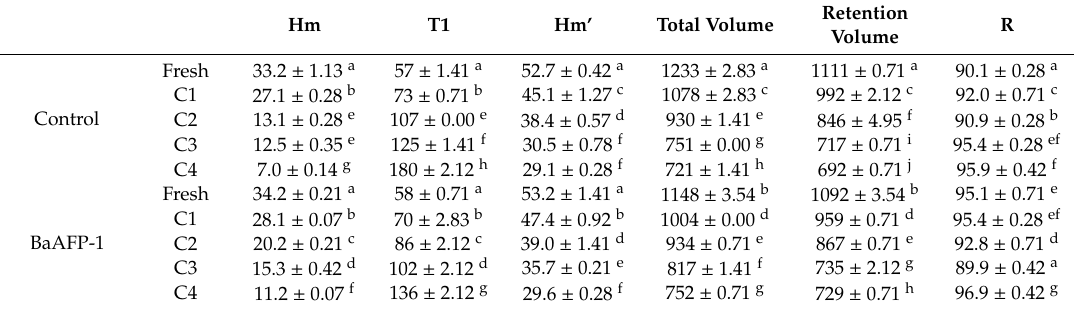
Table 1. E ff ect of BaAFP-1 on fermentation properties of frozen dough after freeze-thaw treatment. Hm T1 Hm’ Total Volume